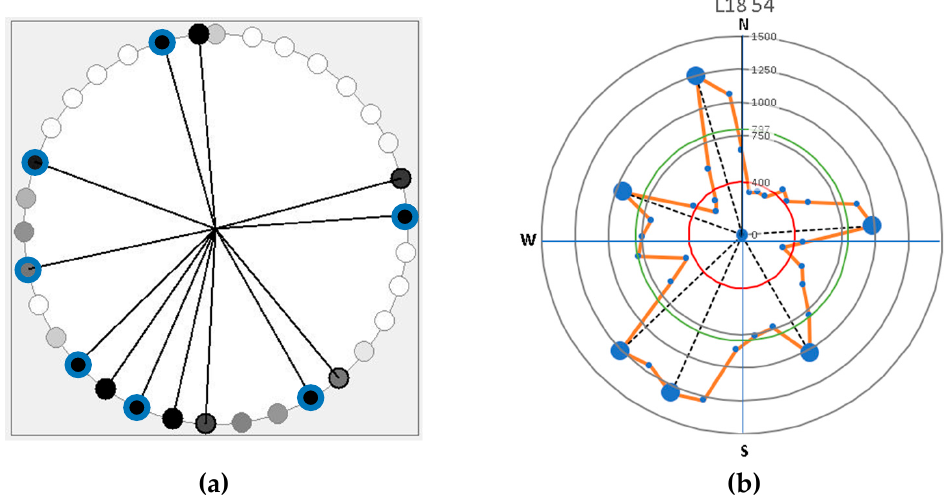
Figure 2. The example of representative graphical visualization of root distribution based on ( a ) Root Detector Evaluation Software (Fakopp Enterprise Bt, Hungary) in which dark circles points out a higher sonic velocity values of main root; and ( b ) sonic velocity and distribution data processing using Microsoft Excel (red line circle is root sonic velocity threshold, green line circle denotes the mean of root sonic velocity value, and the bigger peak dots indicate the main lateral root).